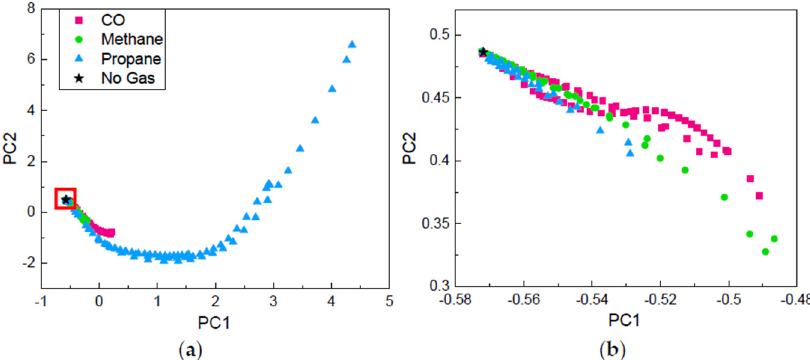
Figure 2. Projections of the segmented time-series dataset onto the two leading principal components for three target gases: ( a ) overall principal component information; ( b ) zoom-in principal component information at initial stage.